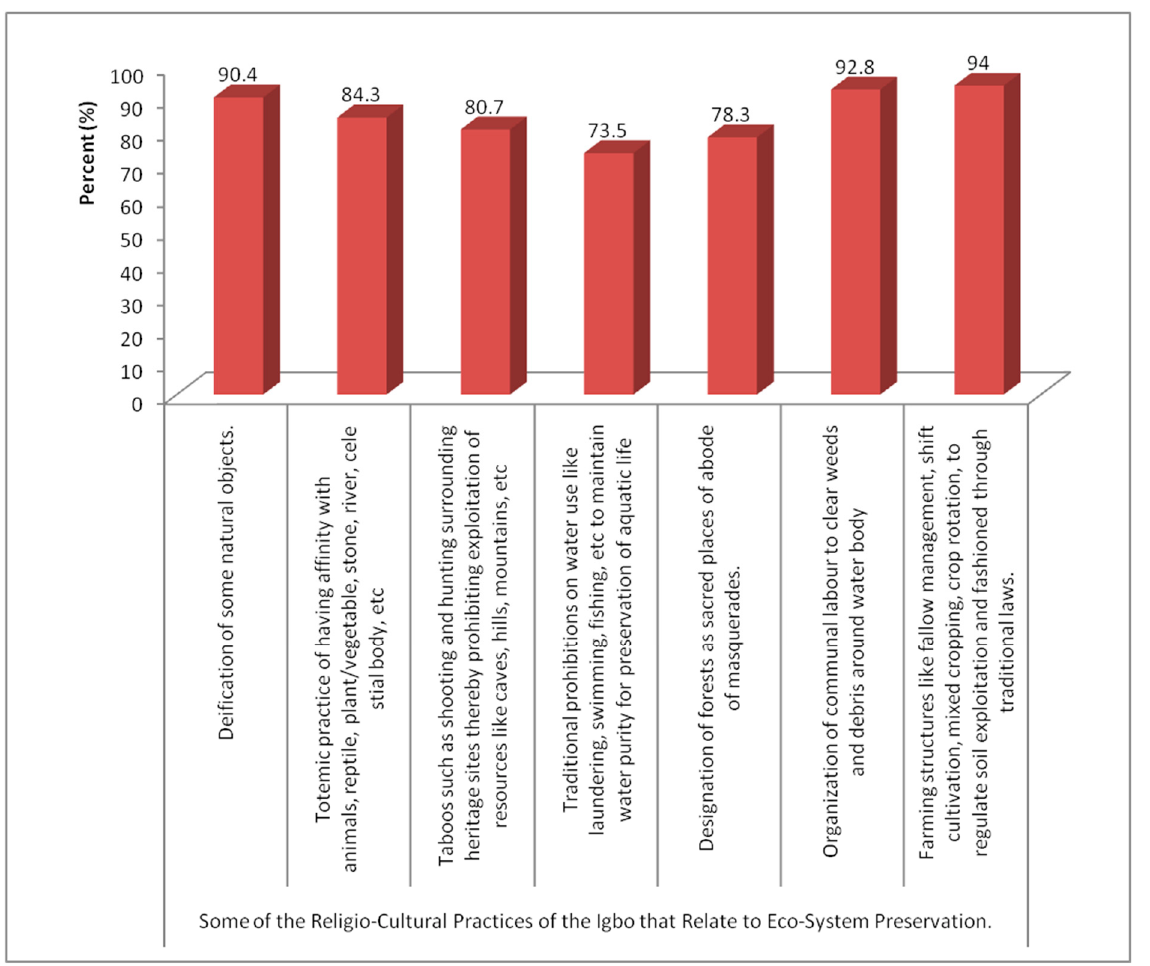
Figure 2. Some of the Religio-Cultural Practices of the Igbo that Relate to Ecosystem Preservation.